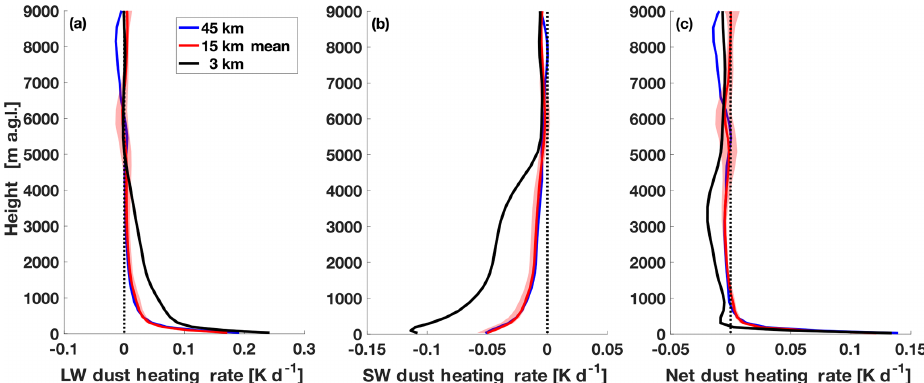
Figure 11. Spatially and temporally averaged longwave (a) , shortwave (b) , and net (c) dust heating rate profile for the 45km (blue), 15km mean (red), and 3km (black) simulations with the maximum and minimum spread across the 15km simulations indicated in light red shading. Plots are truncated at 9km as the values above this height do not significantly vary from what is shown